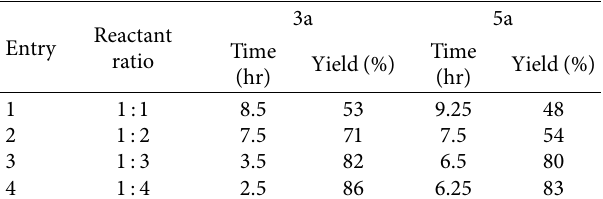
Table 5: Screening of reactant ratio.